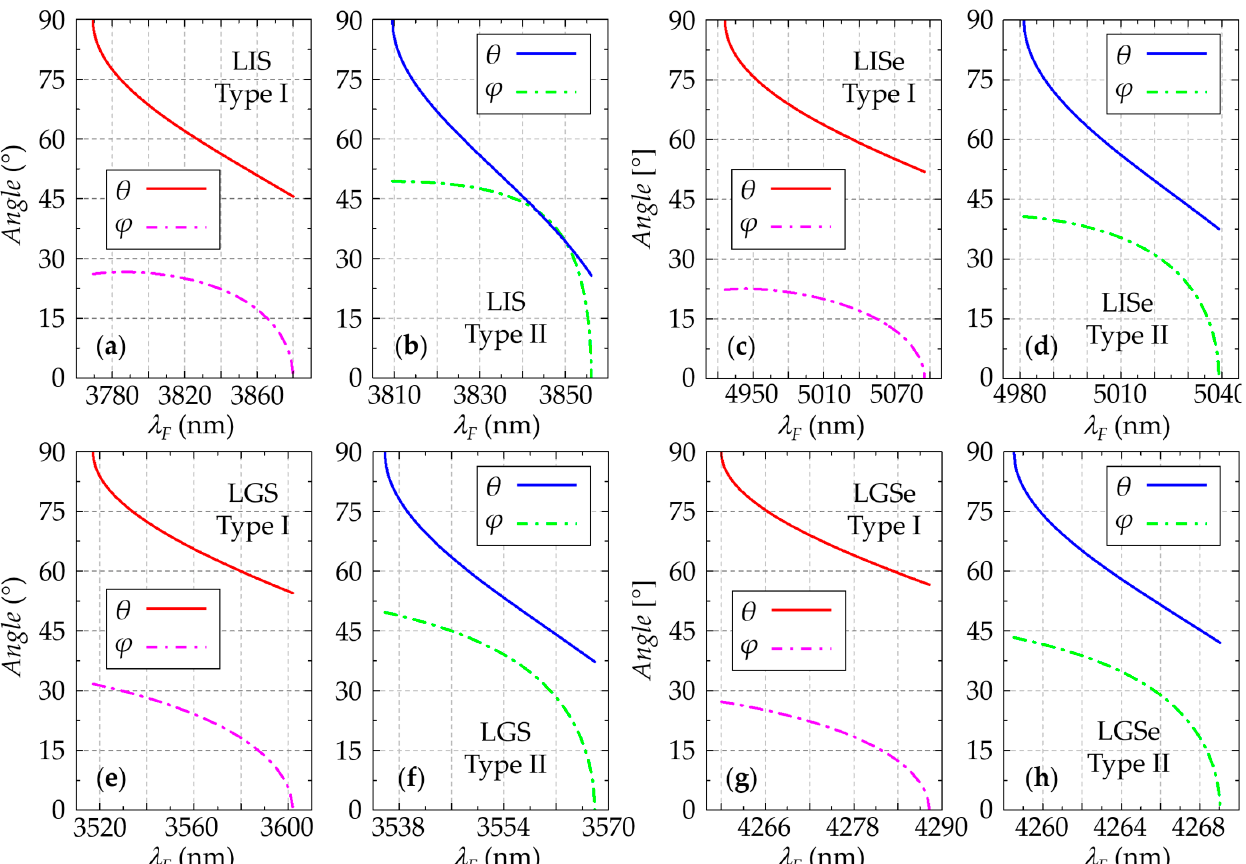
Figure 8. The directions ( θ and φ ) of F-wave vectors plotted as functions of λ F satisfying the broadband SHG conditions. ( a ) Type I and ( b ) Type II in LIS; ( c ) Type I and ( d ) Type II in LISe; ( e ) Type I and ( f ) Type II in LGS; and ( g ) Type I and ( h ) Type II in LGSe. Table 7. Broadband SHG conditions of mid-IR biaxial crystals: the ranges of λ F and λ SH , and the corresponding range of the F-wave vector direction ( θ and φ ).